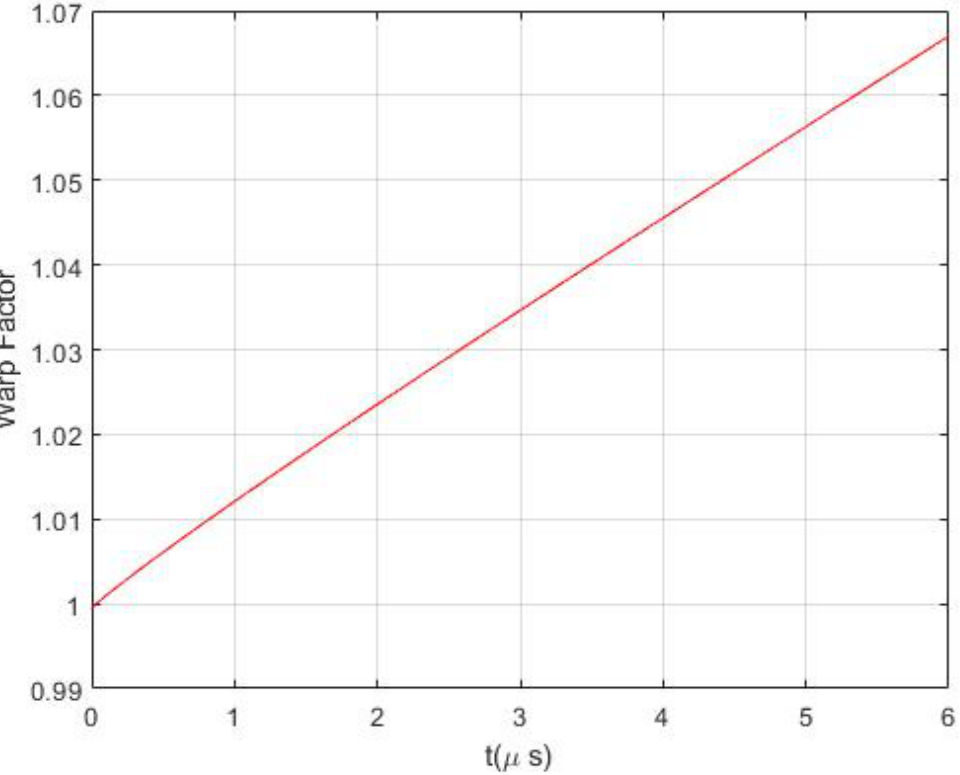
Figure 2. Warp factor for a sin ( ω t ) perturbation with frequency 1 MHz and equation of motion r ( t ) = h 0 + v 0 t + kt 2